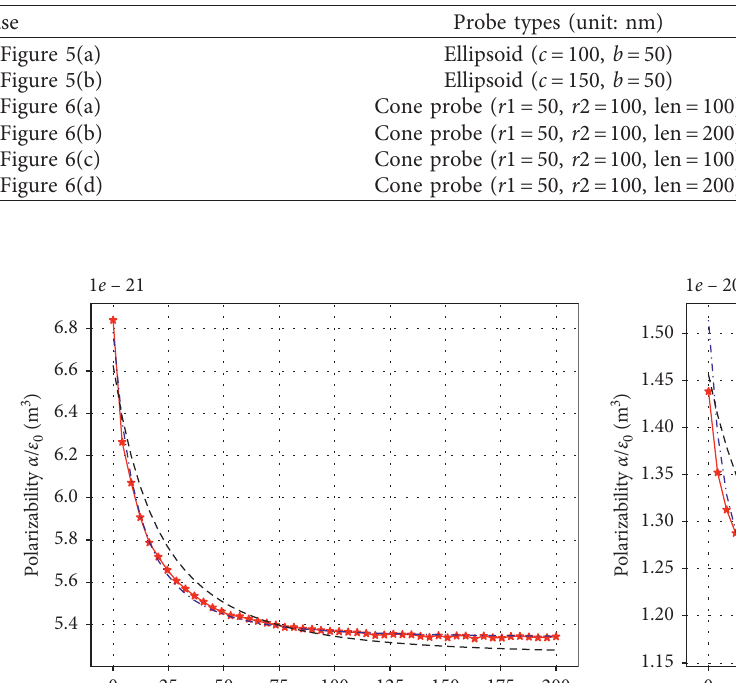
Table 1: Cases of the study for the SNOM probe